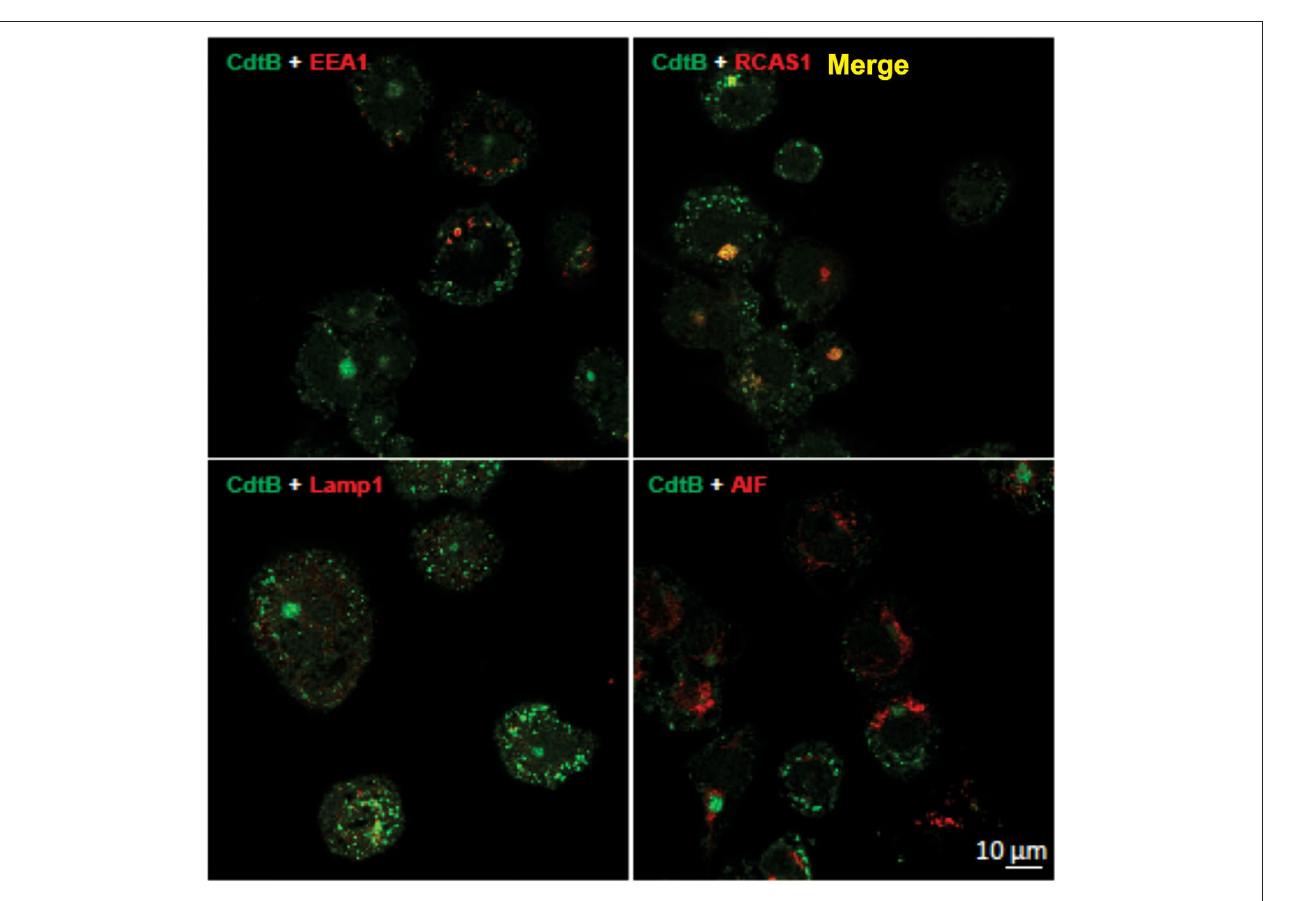
FIGURE 2 | CdtB localizes to early endosomes and Golgi. Confocal micrographs of differentiated THP-1 WT cells treated with Cdt holotoxin and immunostained for the indicated organelle markers (red), CdtB (green), and merge (yellow). EEA1, early endosome; RCAS1, Golgi marker; Lamp1, lysosome marker; AIF, mitochondrial